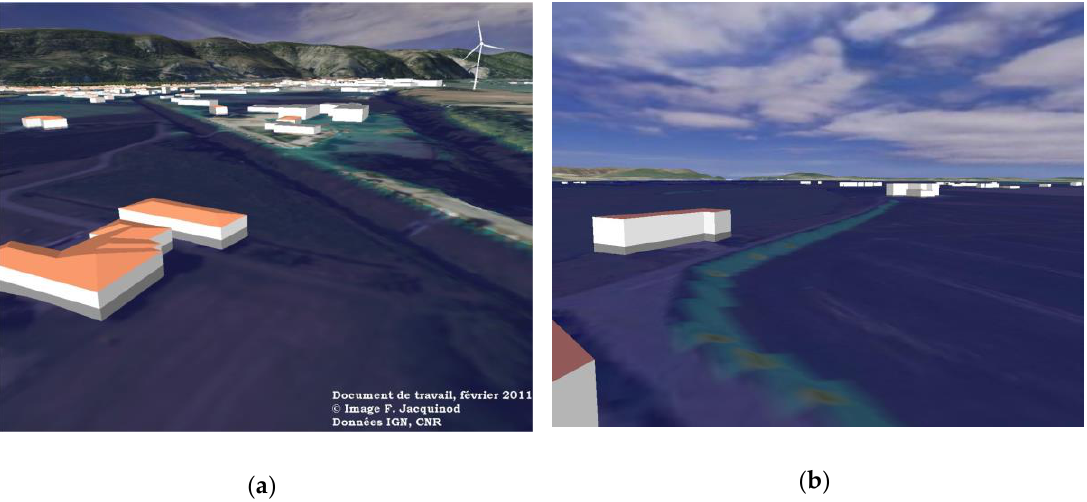
Figure 2. Aerial view from a 3D geovisualization of a district impacted by a simulated flood. ( a ) and ( b ) show how water heights were represented, through a 3D transparent volume. Images prepared F. Jacquinod from data from IGN and by F. Jacquinod from data from IGN and CNR.